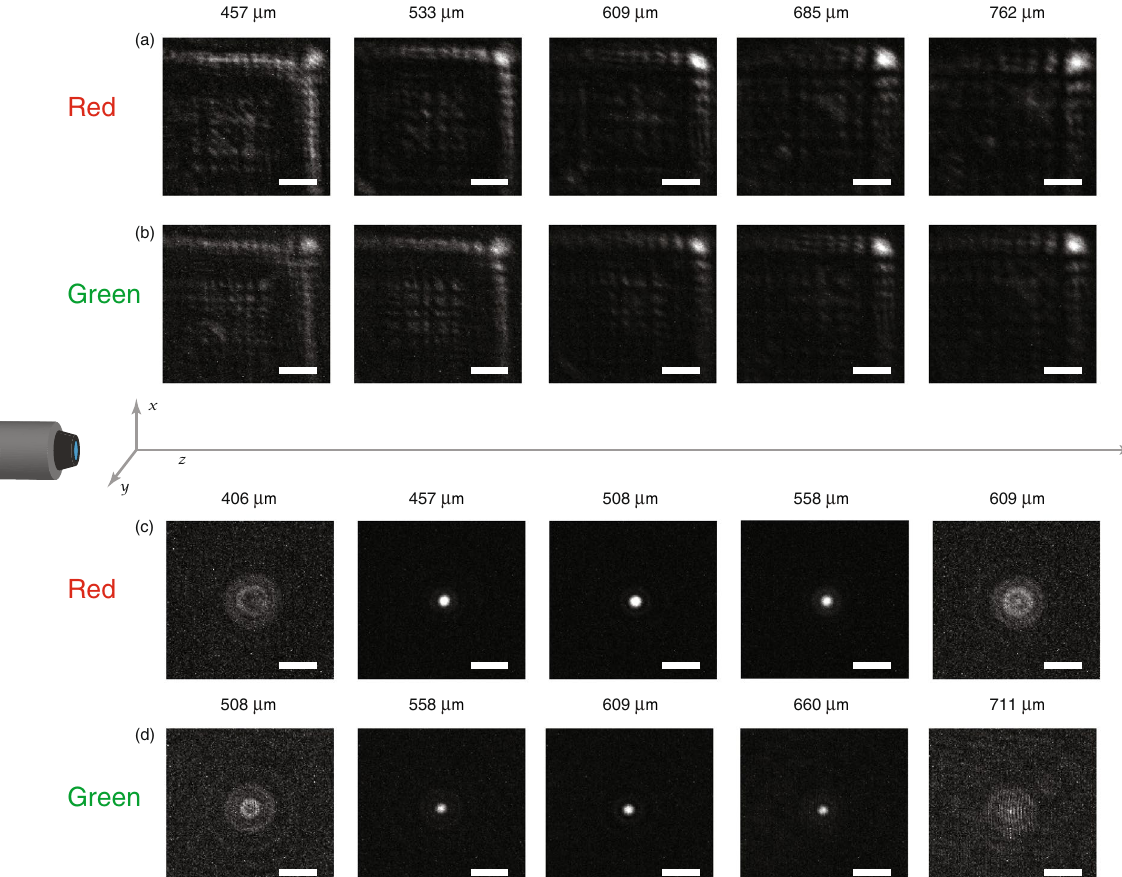
Figure 3. Dependence of cubic metasurface and metasurface lens point spread functions (PSF) upon displacement along the optical axis. ( a ) and ( b ) are the PSFs of the cubic element under coherent illumination by red and green light respectively. ( c ) and ( d ) are the PSFs of a 500 μ m metasurface lens from ref. 24 under red and green illumination. All figures share the same 18 μ m scale bar. The differences in the intensities of the images are due to the difference in incident intensities of the red and green lasers upon exiting the